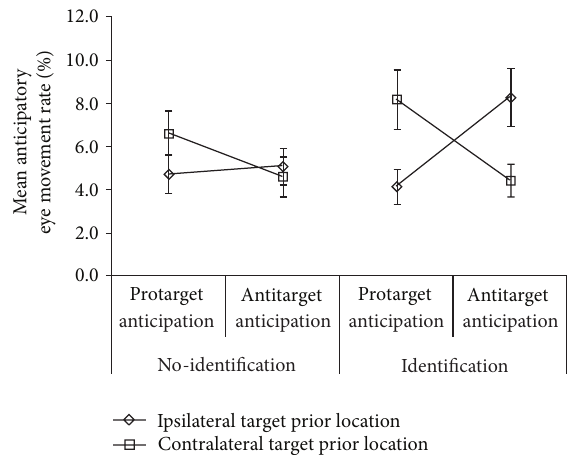
Figure8:MeanfrequencyofanticipatoryeyemovementsunderISR conditions. Anticipatory eye movement three-way interaction for identification × target prior location × anticipatory type for 200 ms gap trials. Error bars = ± 1 SEM.